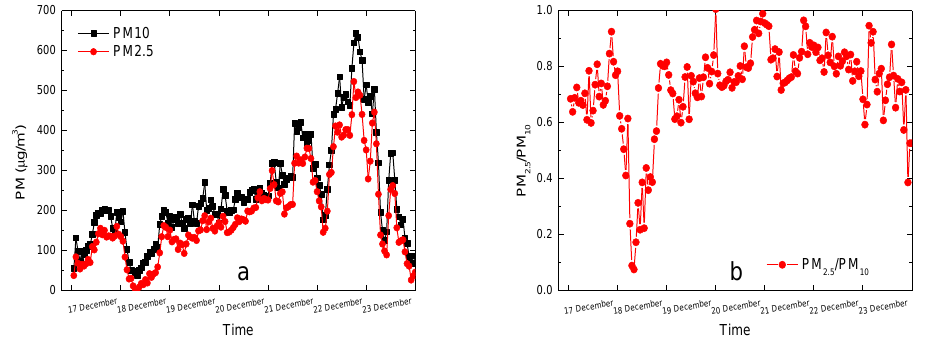
Figure 1. Daily variation of the ( a ) particle mass concentration and ( b ) proportion of PM 2.5 /PM 10 (ground measurement dataset).